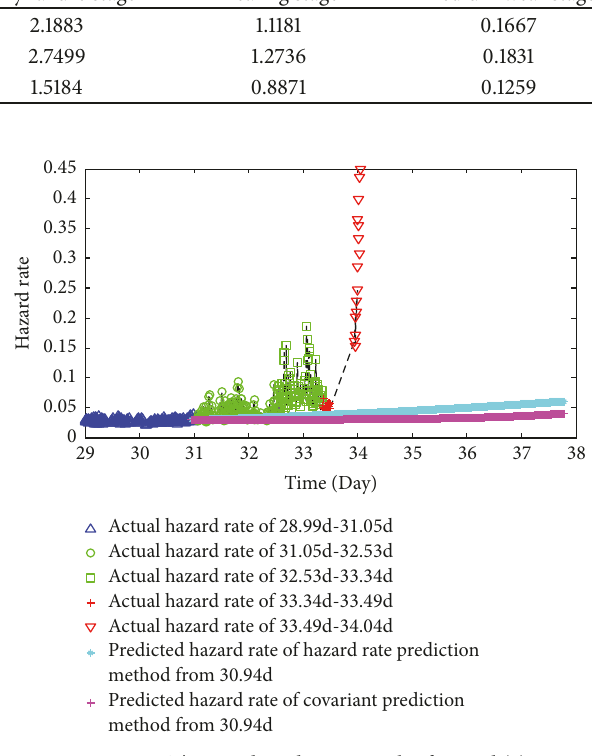
Figure 14: The trend prediction result of period